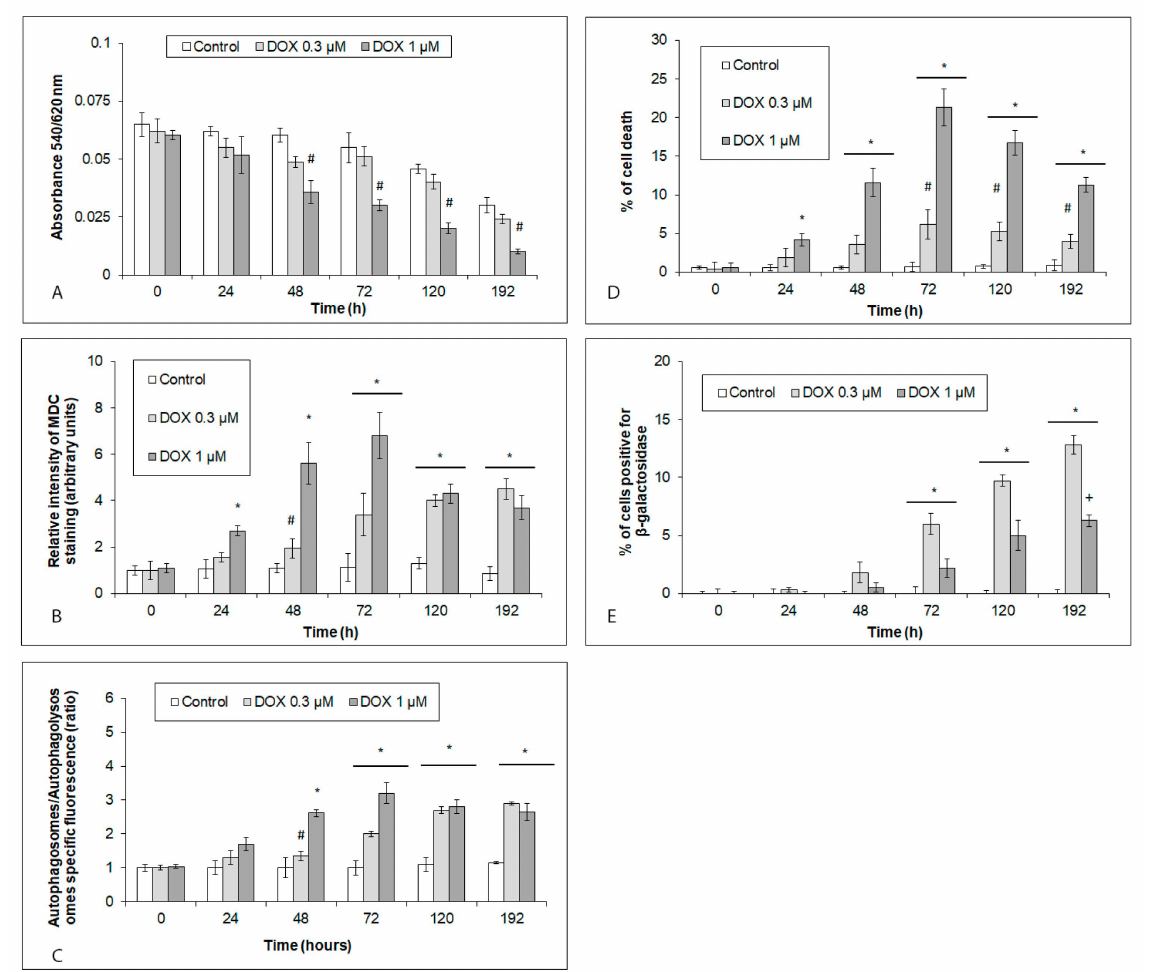
Figure 1. Effects of DOX (0.3 and 1 µ M) on the viability, autophagy, cell death, and senescence of hiPCS-CMs during 192 h, as measured by particular assays described in Section 4. ( A ) Viability, ( B , C ) autophagy, ( D ) cell death, and ( E ) senescence. Values represent means ± SD of N = 3 (viability), N = 4 (autophagy), N = 3 (cell death), and N = 3 (senescence) experiments. * p < 0.05 compared to untreated control cells at the same treatment interval; # p < 0.05 compared to 1 µ M DOX treated cells at the same treatment interval; + p < 0.05 compared to 0.3 µ M DOX treated cells at the same treatment interval with one-way ANOVA test and Dunnett’s post test for multiple